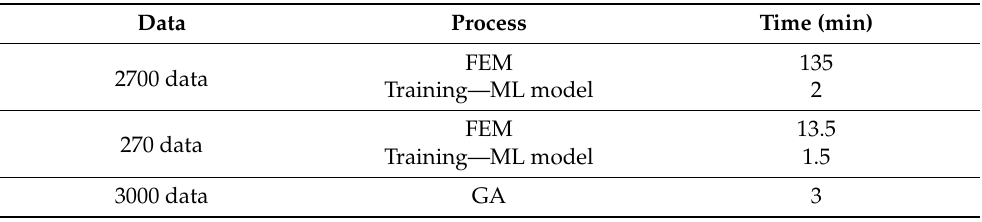
Table 1. A comparison of the time spent by models on different training sets on the entire activity of the theory-guided model design